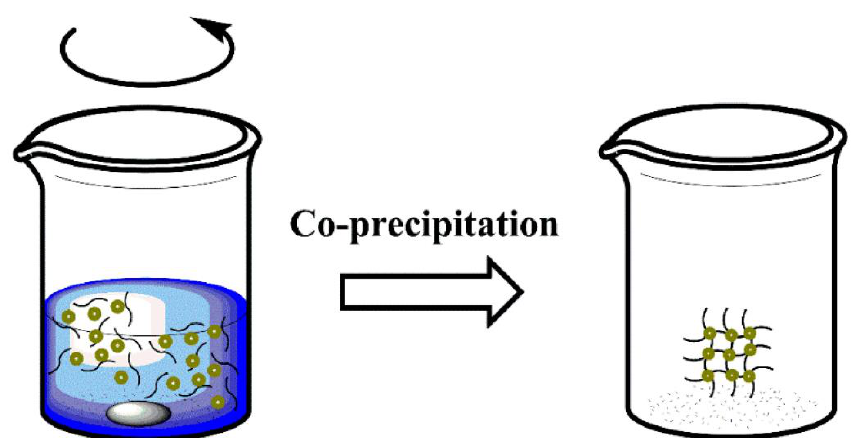
Figure 4. Schematic representation of co-precipitation method. Reprinted with permission from ref. [57], MDPI, 2022.